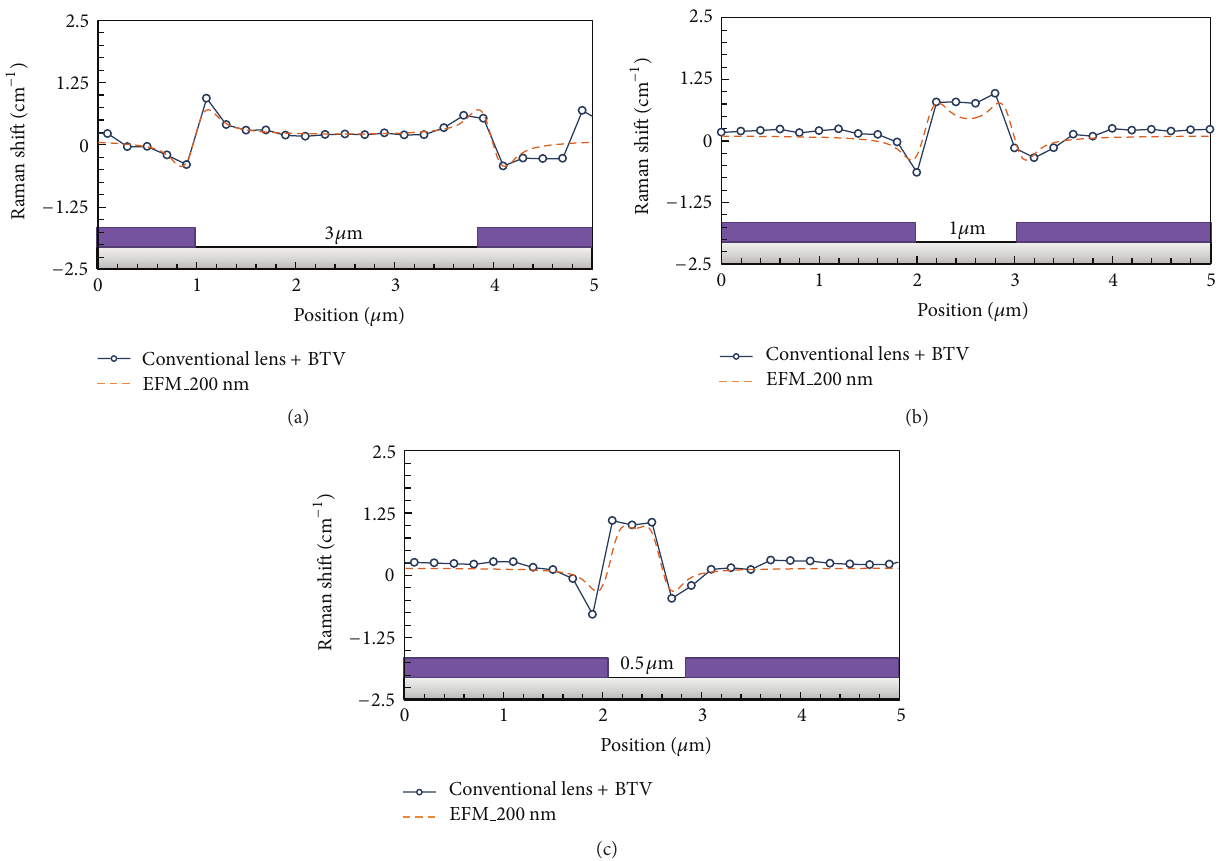
Figure 7: One-dimensional profiles of Raman shifts in the center of L&S pattern obtained by super-resolution Raman spectroscopy and EFM calculation with conventional lens (in space widths of (a) 5, (b) 3, and (c) 1 𝜇 m).